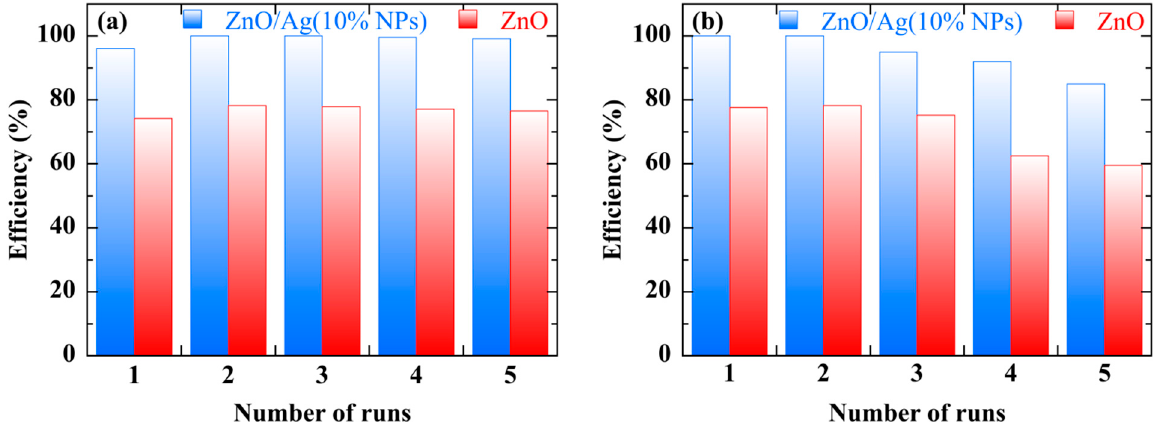
Figure 17. Photodegradation efficiency by a ZnO/Ag(10% NPs) photocatalyst under solar illumination of an IC solution prepared with deionized water ( a ) and Somme water ( b ), during 5 cycles of 4 h.